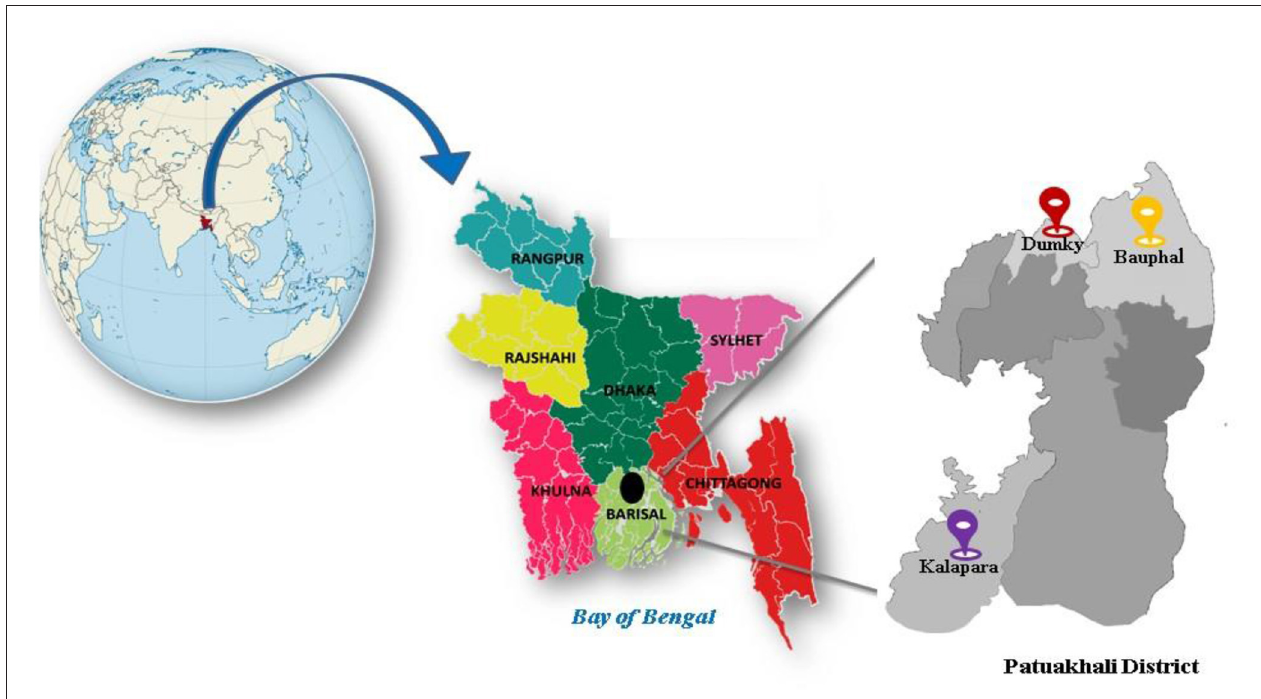
FIGURE 1 | Sampling sites of Patuakhali district,